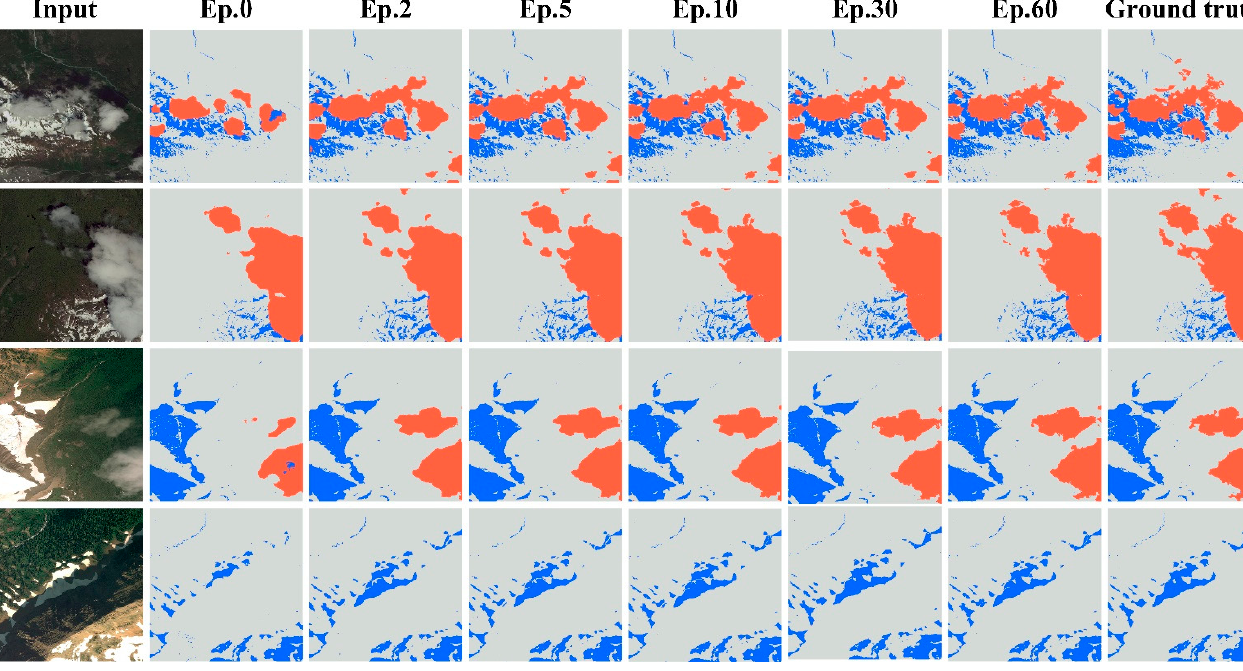
Figure 20. The examples of transfer learning prediction results on the CSWV_M21. The number at the top indicates how many epochs of transfer learning were performed on the target dataset.